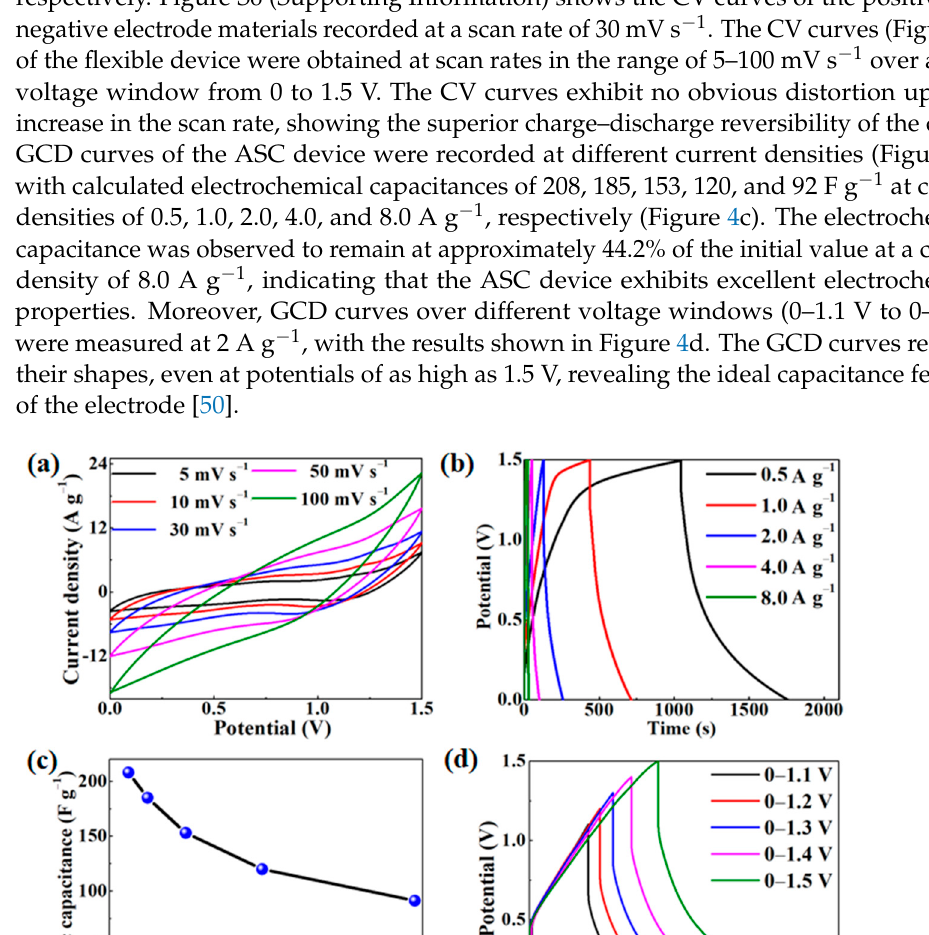
Figure 4. ( a ) CV curves of the flexible asymmetric device, recorded at different scan rates. ( b ) GCD curves of the flexible asymmetric device recorded at different current densities. ( c ) Specific capaci- tance of the flexible asymmetric device recorded at different current densities. ( d ) GCD curves of the flexible device recorded at a current density of 5 A g − 1 over different potential ranges (0–1.1 V to 0–1.5 V). ( e ) GCD curves of the flexible device with different bending angles at a current density of 5 A g − 1 . ( f ) Cycling performance of the flexible asymmetric device at a current density of 1 A g − 1 and EIS data of the flexible ASC device before and after 10,000 cycles (inset). 3.3. Stability and Flexibility Properties It is well known that electrochemical durability is a crucial parameter of SCs. Hence, the electrochemical cycling stability of the MoS 2 /Gr electrode was also assessed at 1 A g − 1 over 10,000 cycles, with the results shown in Figure 3d. The CV curves of before and after the 10,000 cycles test are shown in the inset of Figure 3d. It was found that 89.6% of the initial electrochemical capacitance of the MoS 2 /Gr electrode was retained after long-term cycling, indicating that the MoS 2 /Gr heterostructure exhibits excellent electrochemical cy- cling stability. This superior electrochemical cycling stability can be attributed to the growth of flower-shaped MoS 2 on the Gr, which significantly enhances the structural sta- bility of the electrode. Furthermore, the ASC device was tested at various angles (0°, 30°, 60°, 90°, and 180°) to examine its flexibility. Figure 4e shows the GCD curves of the flexible ASC device twisted at different bending angles at 2 A g − 1 . The corresponding CV curves are presented in Figure S7 in the Supporting Information. Note that the shapes of the GCD and CV curves are almost identical after multiple bending tests, indicating the excellent flexibility of the device. Figure 4f presents the long-term cycling stability of the flexible ASC device at 0.5 A g − 1 , in which it can be seen that 86.5% of the electrochemical capacitance was re-